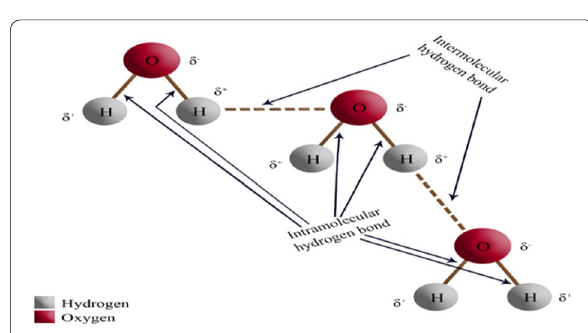
Fig. 2 A schematic diagram shows the types of hydrogen bonds in